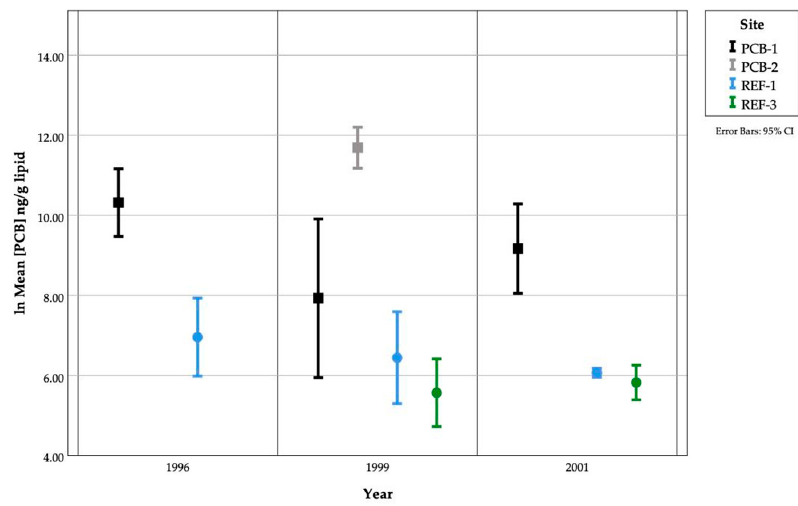
Figure 4. PCB concentrations in fish from Johnston Atoll from three sampling years. Note that these are natural log-transformed data. Table 4. Summary of mean (SD) fish parameters collected from the Johnston Atoll lagoon for contaminant analyses. Within a year, PCB concentrations with the same superscript letter are not significantly different while sites with different letters are significantly different at p <